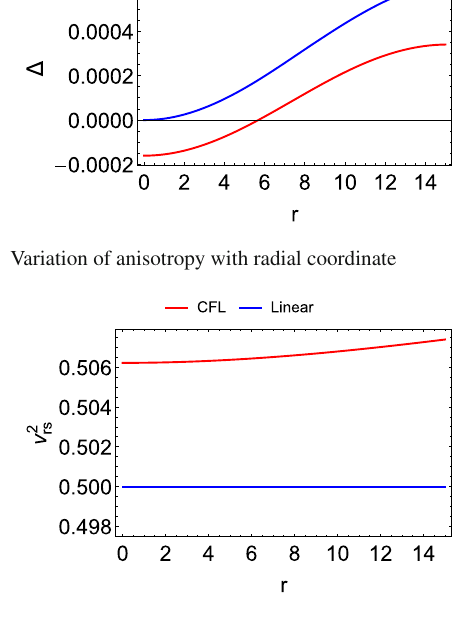
Fig. 5 Variation of radial speed with radial coordinate